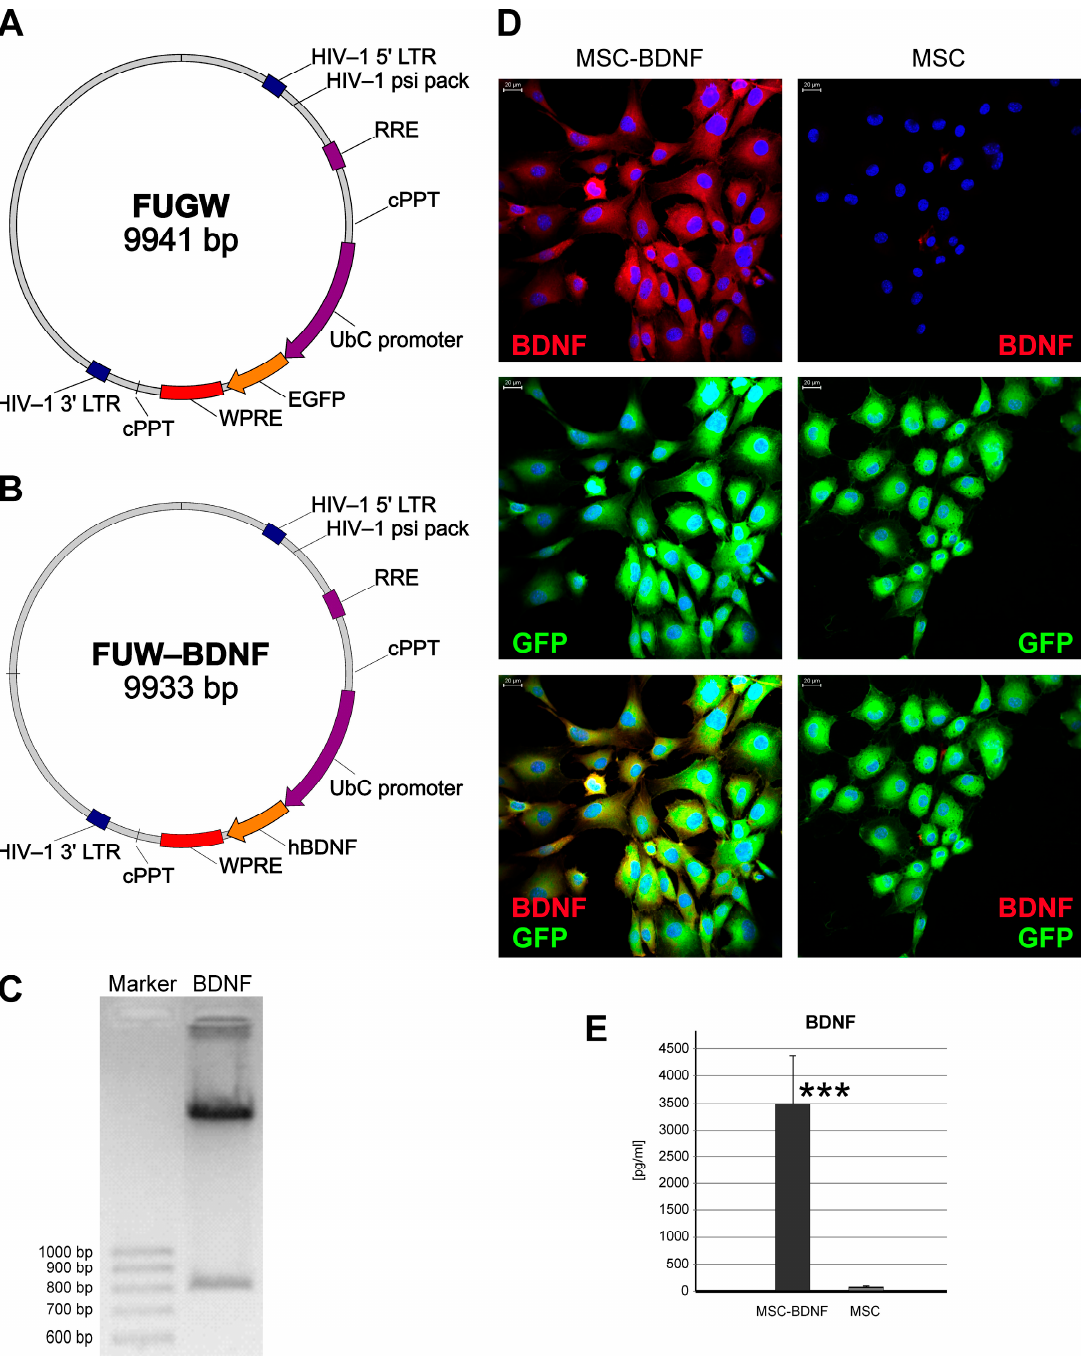
Figure 1. Characterization of lentiviral MSCs transduction efficiency. The schemes of plasmids used for lentivirus production for subsequent murine MSCs transduction are shown. The lentiviral backbone plasmid (FUGW) contained the green fluorescent protein (GFP) coding sequence ( A ) that was removed to insert the human BDNF sequence and then FUGW-BDNF plasmid was created ( B ) for relevant lentiviral vectors production. The correct band for BDNF insert (765 bp) was observed under ultraviolet (UV) light in agarose gel ( C ). Quantitative analysis of BDNF levels from MSC-BDNF and unmodified MSC cultures in vitro ( D ). Noninfected control MSCs produced only trace amount of BDNF, whereas production of BDNF in MSC-BDNF culture was approximately 35-fold increased. These data were corroborated by double immunofluorescent staining of BDNF and GFP proteins for their qualitative expression and co-expression analysis ( E ). Scale bar: 20 µ m, *** p <